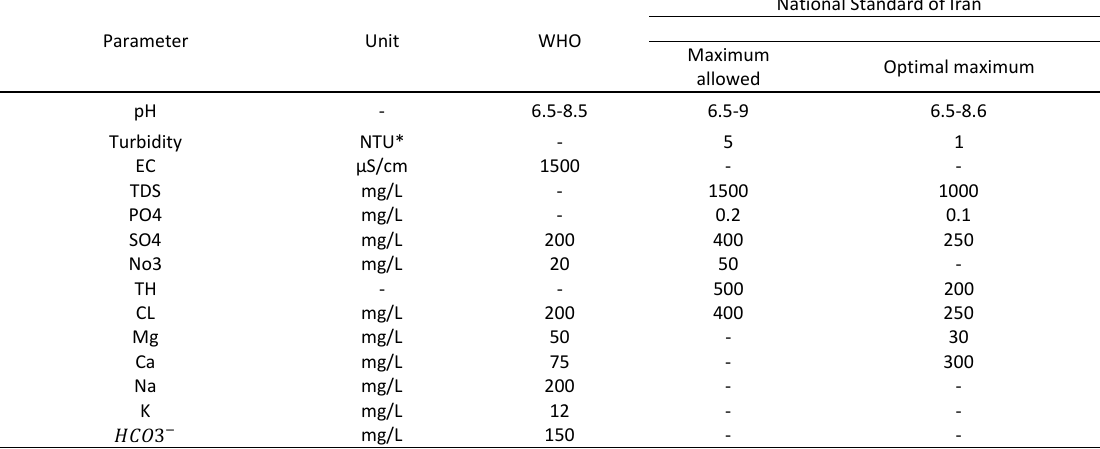
Table1. Permissible values of measured parameters according to the national standard of Iran and the WHO (WHO, 2011)